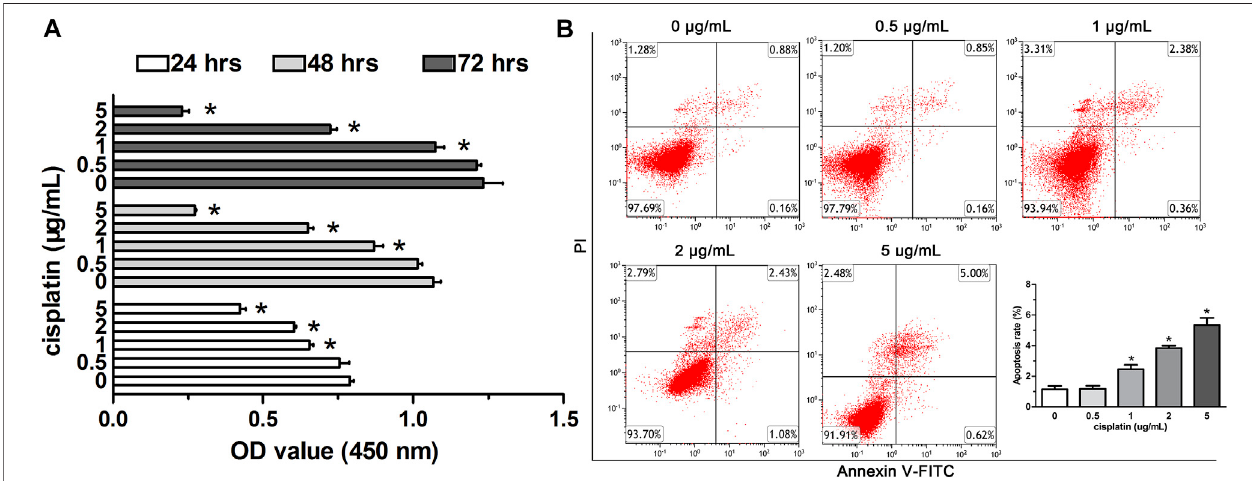
FIGURE 1 | Effects of low-dose cisplatin treatment on the viability of A549 cells. (A) Cell proliferation of A549 cells was detected by the CCK-8 method after incubation withdifferentconcentrationsofcisplatin (5, 2,1, 0.5, 0 g/mL) for 24,48, and 72 h, respectively. As shown in (A) , theproliferation ofA549cellsincubated with low-dose (0.5 μ g/ml) cisplatin was similar to that of A549 cells incubated without cisplatin during the whole experiment duration (* p > 0.05). (B) Apoptosis of A549 cells was assessed with Flow cytometry analysis after being treated with different concentrations of cisplatin (5, 2, 1, 0.5, 0 g/mL). PI staining was indicated as red fl uorescenceandAnnexinVasgreen fl uorescence.Asshownin (B) ,apoptosisofA549cellswasnotaffectedbythelow-dosecisplatin(0.5 μ g/ml)comparedwiththatof controls (A549 cells treated without cisplatin, * p > 0.05). Each experiment was conducted in triplicate and the data were expressed as mean ± SD.